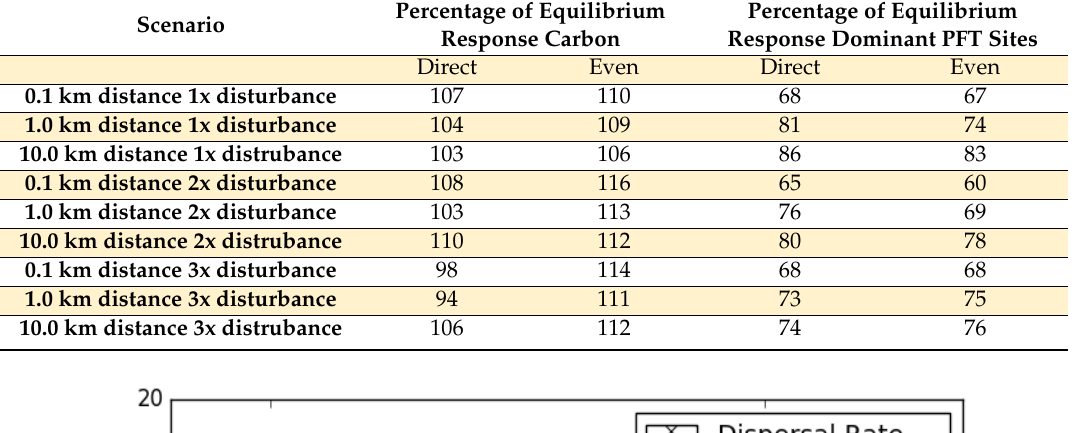
Table 1. The listed percentage of the equilibrium responses total carbon and the percentage of dominant PFT sites matched that each scenario had obtained by the final simulation year.